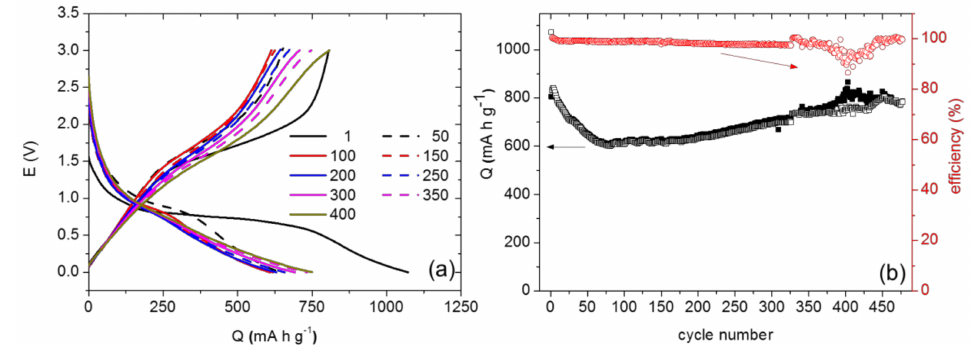
Figure 10. ( a ) Discharge-charge curves at 2C and ( b ) specific capacity versus cycle number at different rates, for the FO-Sep@C-400 composite vs. Li +